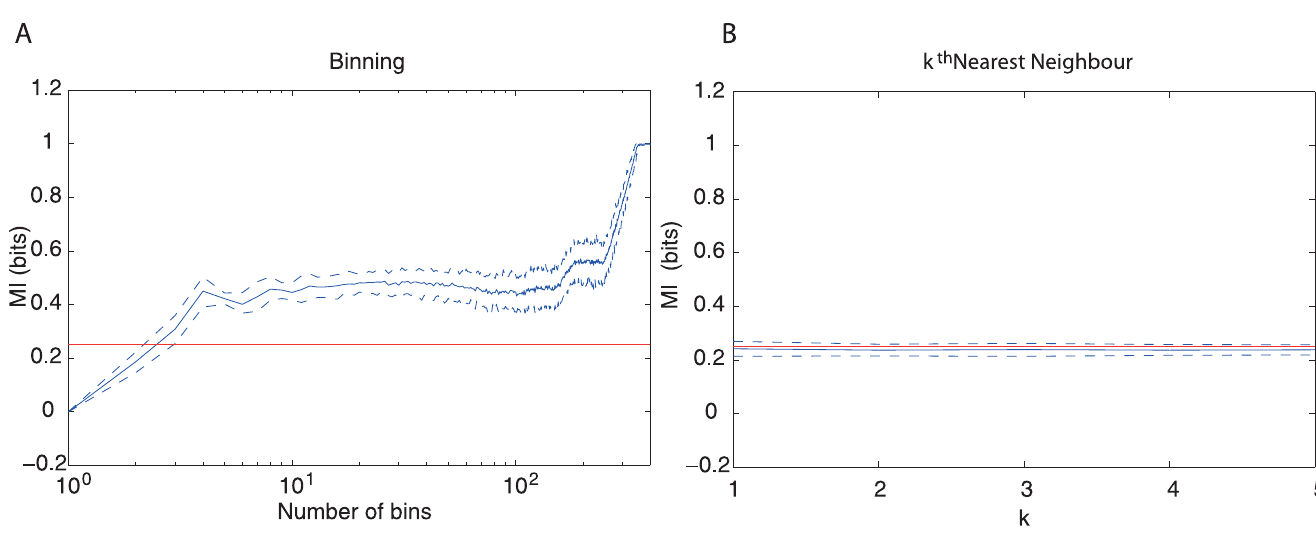
Fig 1. Simulation for uniform conditioned probability. (A) MI estimation using the binning method with QE correction, as a function of the number of bins used. (B) MI estimation using the method of the k th nearest neighbours, as a function of the chosen k value. Sample size was N = 400, red line indicates the true value of MI, blue line indicates mean MI value for 100 data sets of size 400 each. The interval between dashed blue lines indicates 10% lowest to 10% highest estimates.